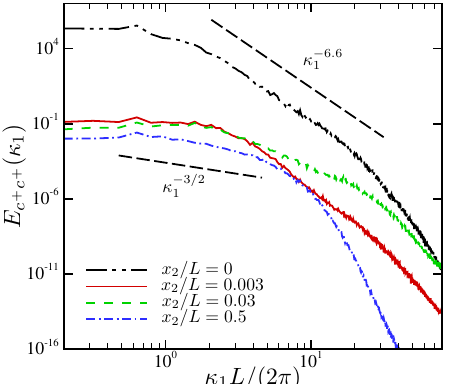
Figure 11. Spatial power spectral density of cation concentration for